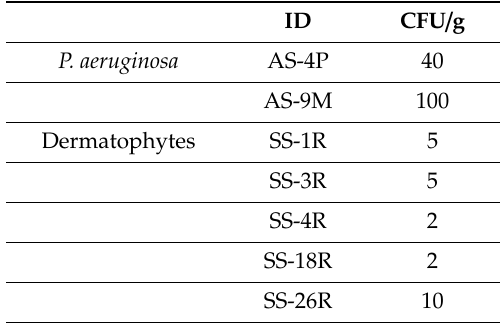
Table 7. Positive samples for Pseudomonas aeruginosa or dermatophytes. Dermatophytes were found in